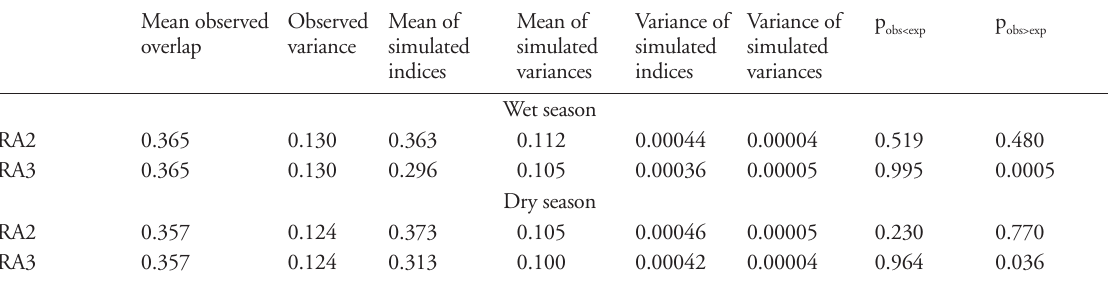
Table 3. Niche overlap analysis with null models for the studied community of amphibians, during the wet season and during the dry season. Two randomization algorithms (RA2 and RA3) of Lawlor (1980) were used for this analysis with 30 000 Monte Carlo